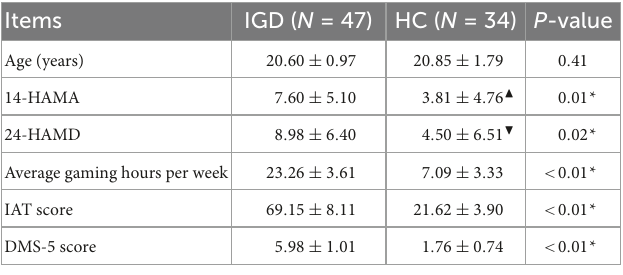
TABLE 1 Demographic characteristics and clinical information of young people with internet gaming disorder (IGD) and healthy controls (HC).